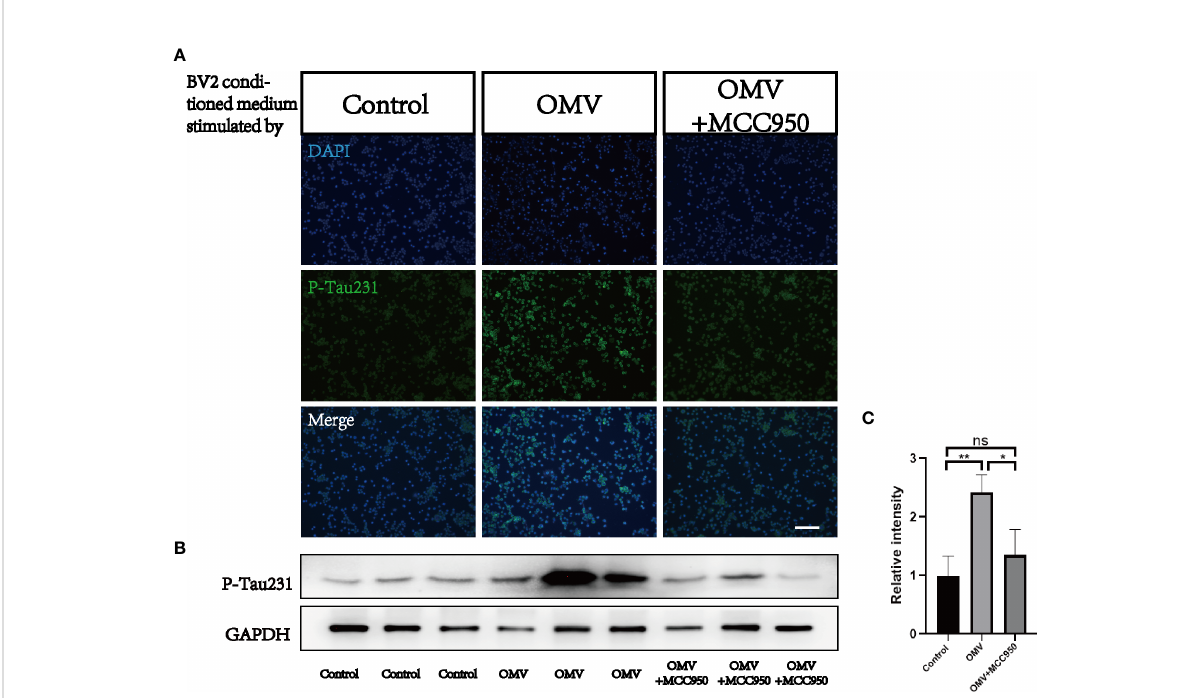
FIGURE 10 Microglia-conditioned medium (MCM) stimulated by Pg OMVs contributes to tau hyperphosphorylation in cultured neurons. (A) Immuno fl uorescent images of P-Tau231 in N2a cells treated with MCM from control, Pg OMV – primed MCM, or Pg OMV – primed MCM pretreated with NLRP3 inhibitor for 24 hours. (B) The Western blot images of P-Tau231 in N2a cells treated with MCM from control, Pg OMV – primed MCM, or Pg OMV – primed MCM pretreated with NLRP3 inhibitor for 24 hours, samples from three independent experiments are shown. (C) The quantitative analyses of immunoblots in image (B) ( n = 3, * p <.05, ** p <.01). (ns: p